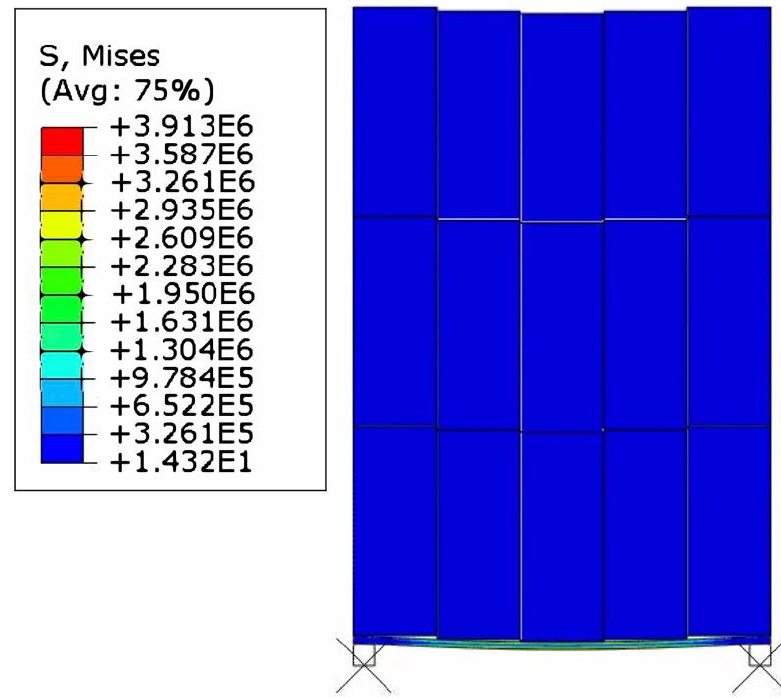
Figure 7. Plot of the equivalent Von Mises (MPa) stress of the unit load segment under a 5-column payload.